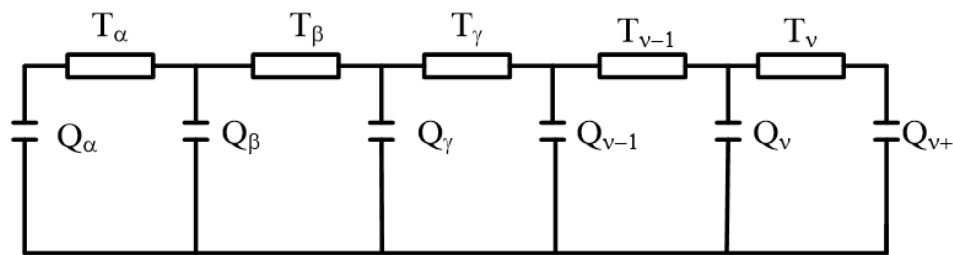
Figure 3. Cable system ladder circuit.